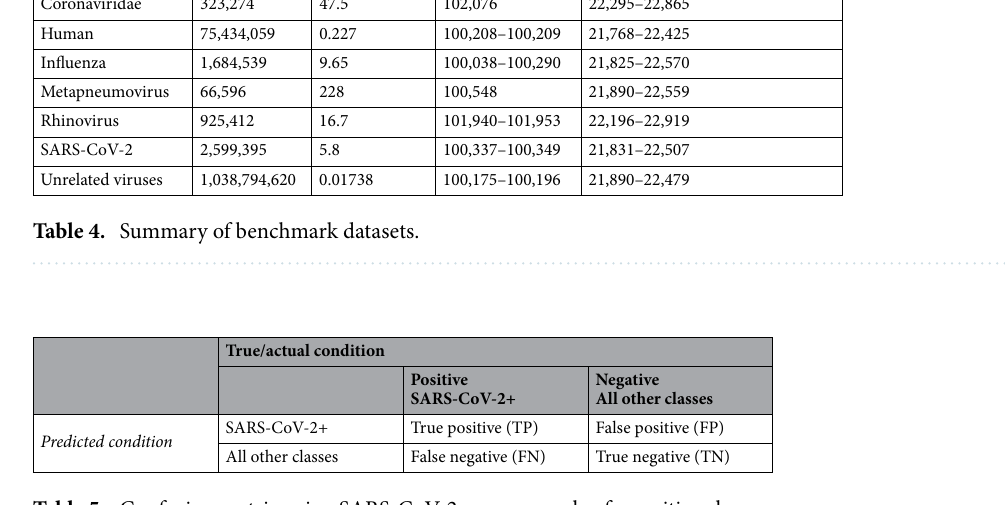
Table 5. Confusion matrix using SARS-CoV-2 as an example of a positive